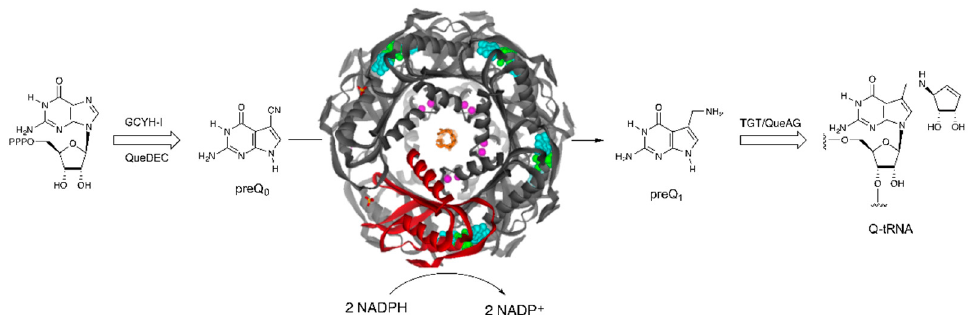
Figure 1. The QueF ‐ catalyzed reaction in the queuosine biosynthesis pathway.